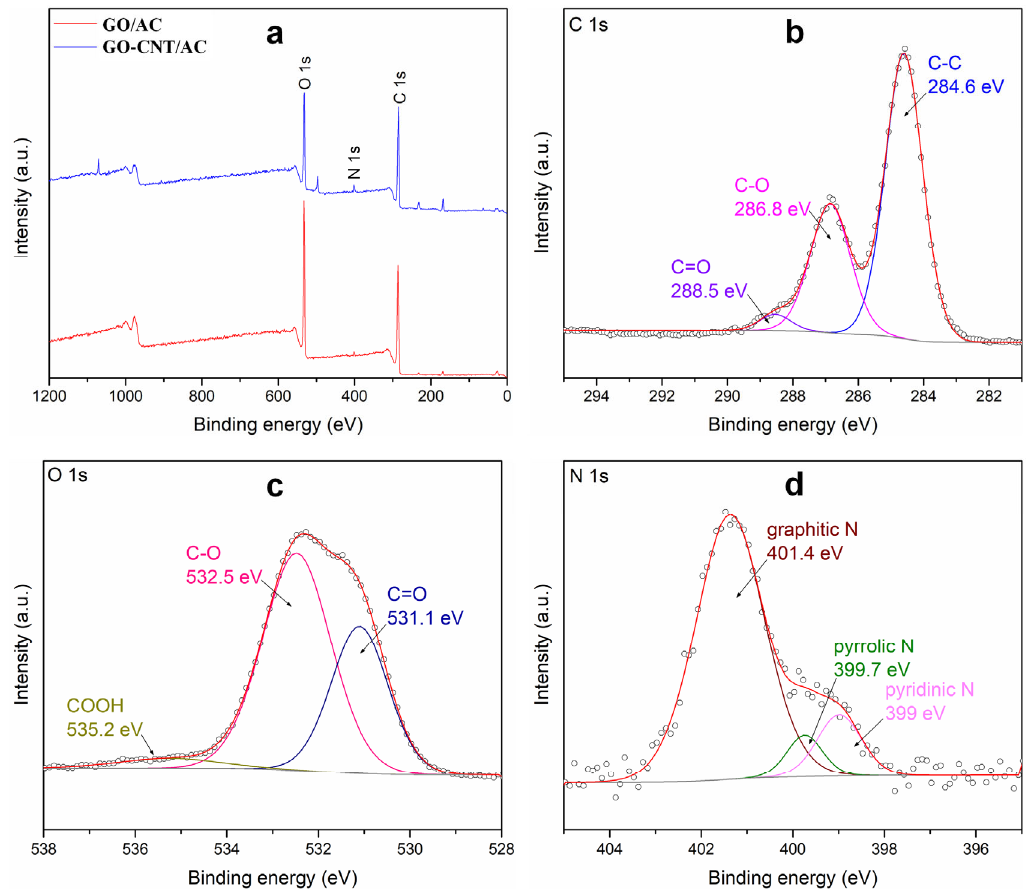
Figure 4. XPS full spectrum of GO/AC and GO ‐ CNT/AC composite ( a ), and the fine spectrum of C 1s ( b ), O 1s ( c ), N 1s ( d ) in GO ‐ CNT/AC